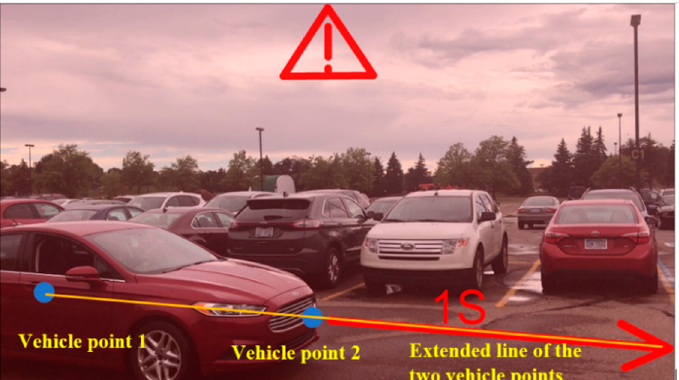
Figure 10. Example of scenario 4: Conflict position could not be projected.